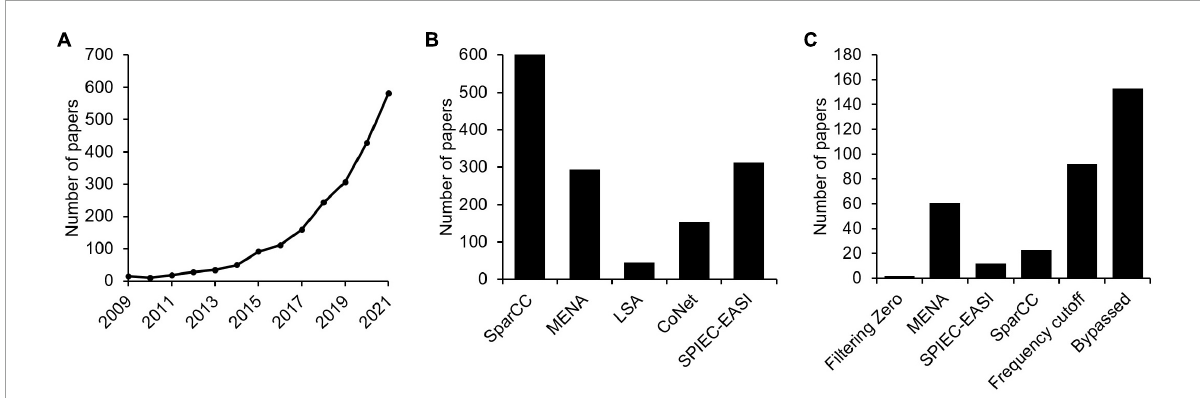
FIGURE2 The current situation of implementing microbial association network analyses in microbial ecological and environmental studies by analyzing published literatures. (A) Using the keywords "microbial ecological network" and "microbial co-occurrence network," the number of papers published in the NCBI PubMed database in the past 13 years was analyzed. (B) Citations of different microbial association network construction methods. (C) The number of papers whether missing values were considered when constructing microbial association